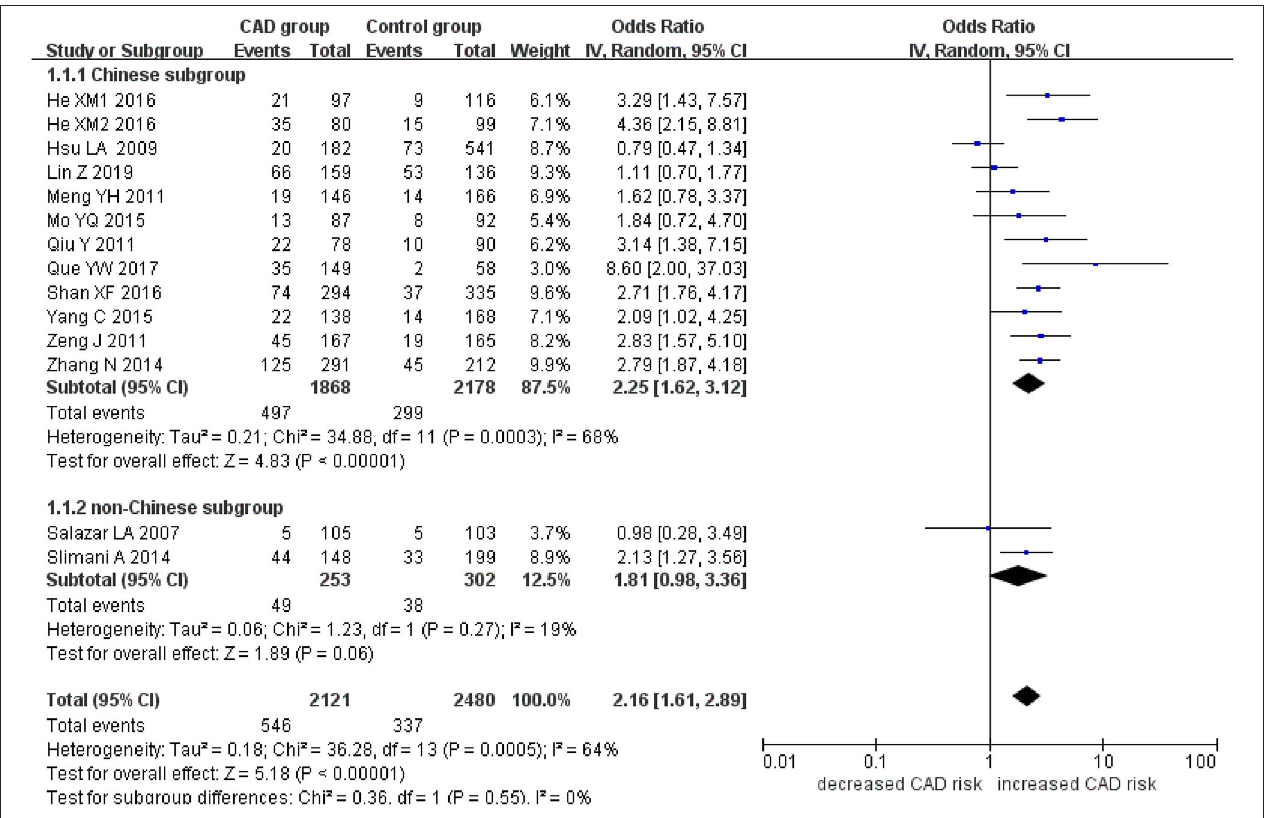
FIGURE 2 | Forest plot of CAD associated with PCSK9 gene E670G polymorphism under a dominant genetic model (AG + GG vs. AA).